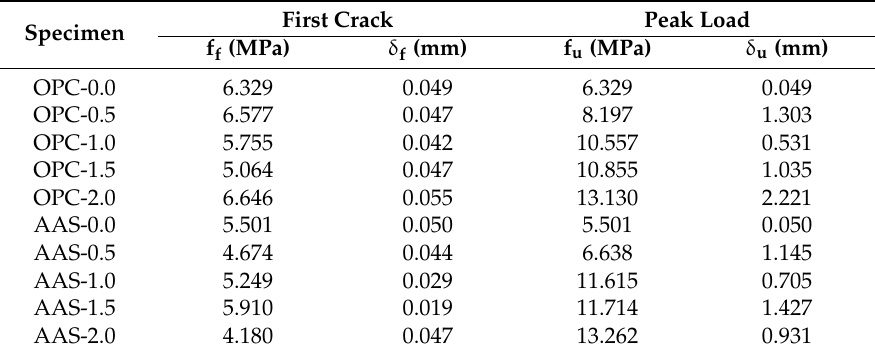
Table 5. Strengths and deflections at both first crack and peak load.